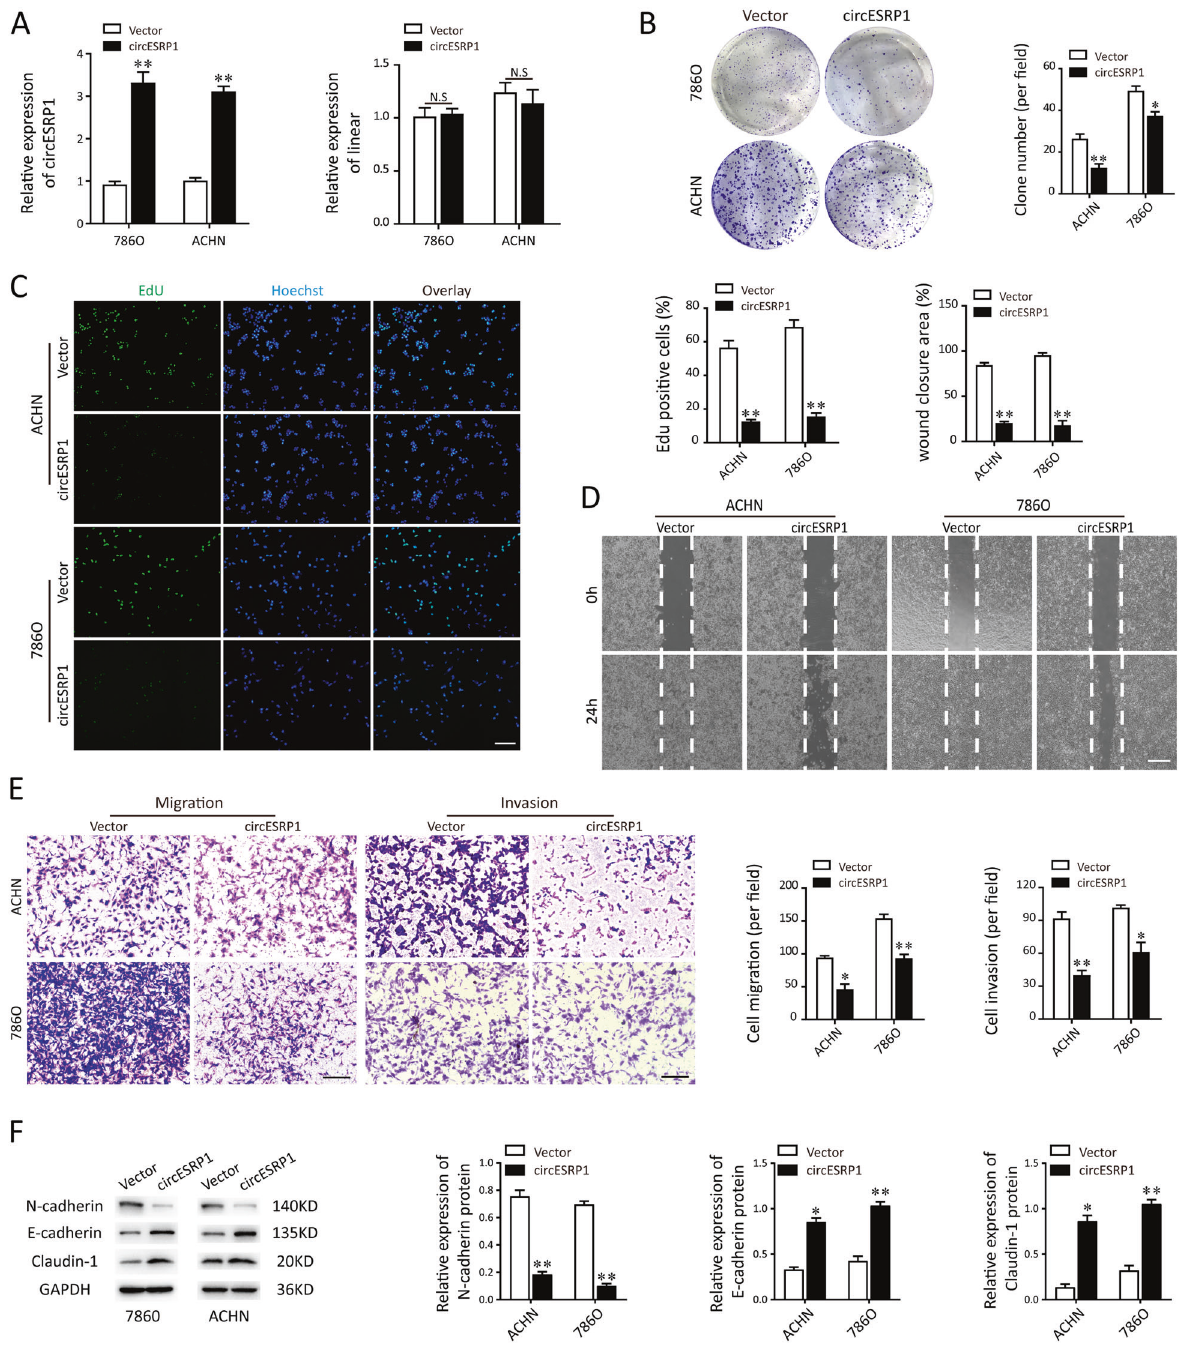
Fig. 2 Overexpression of circESRP1 suppressed renal cancer progression. A ccRCC cells that stably overexpressed circESRP1 were constructed. The circESRP1 and linear ESRP1 mRNA level were measured using qRT-PCR. B Colony formation assay was performed in both 786O and ACHN cell lines after overexpression with circESRP1. C Cell proliferation rate in ccRCC cells (786O, ACHN) under the speci fi c conditions was performed by EdU assay. Scale bar: 100 μ m. D , E The biological role of circESRP1 on cell migration and invasion capability was assessed by wound healing assay ( D , scale bar: 200 μ m), transwell migration assay, and matrigel invasion assay ( E , scale bar: 50 μ m) and in 786O and ACHN cells, respectively. F The protein markers of EMT, including mesenchymal markers (N-cadherin) and the epithelial marker (E- cadherin, Claudin-1), were measured by western blot analysis. Data are the means ± SEM of three independent experiments. * p < 0.05; ** p < pathogenic process of RCC. To explore the candidate miRNAs that relationship. Recent studies have reported that circRNAs can contained putative targeting regions for CTCF, 1078 miRNAs were function as miRNA sponges to regulate gene expression [26, 27]. selected from the prediction results through TargetScan (http:// RNA immunoprecipitation (RIP) analysis revealed that circESRP1 www.targetscan.org/) and miRDB (http://mirdb.org/). Meanwhile, was signi fi cantly enriched by the AGO2 antibody (Fig. 4A, P < online bioinformatics tool CSCD (http://gb.whu.edu.cn/CSCD/) 0.05), suggesting that circESRP1 may act as a ceRNA in the